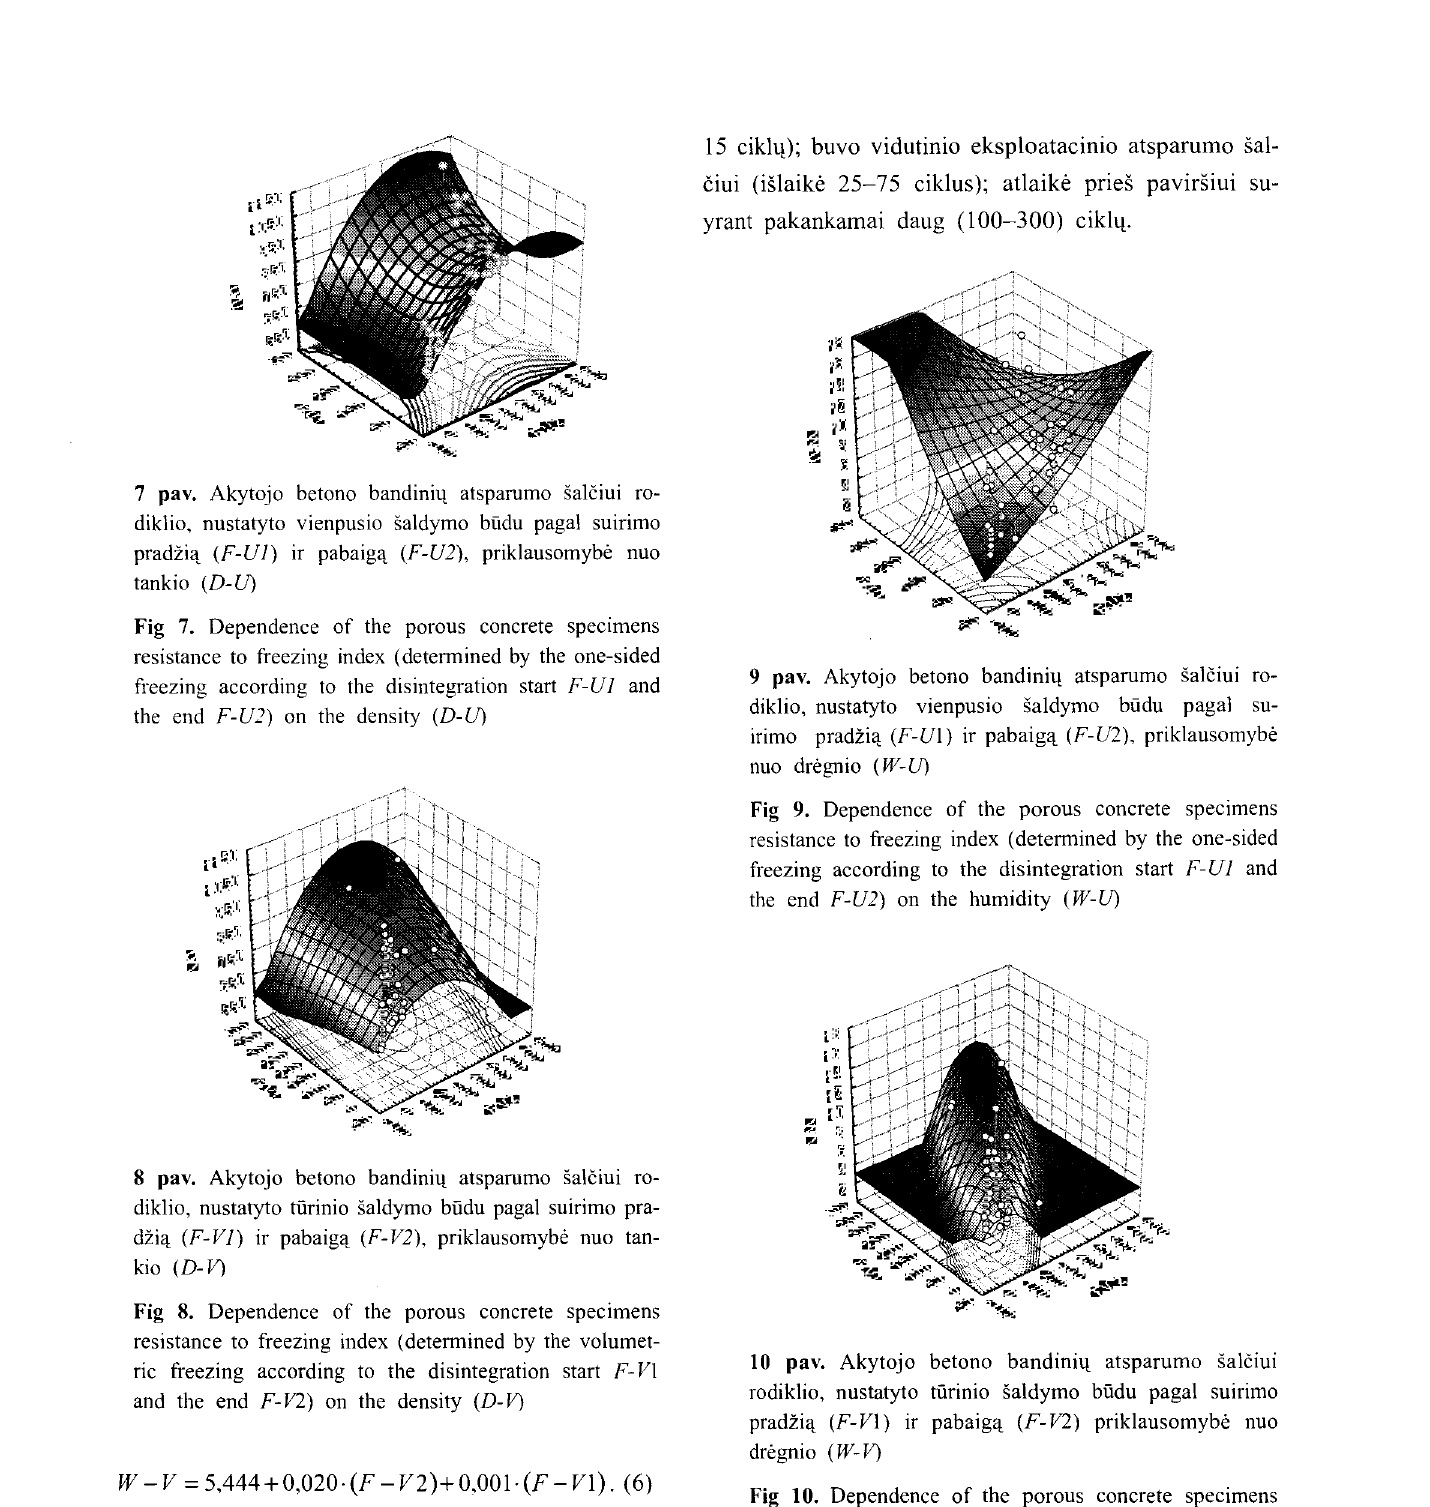
Fig 10. Dependence of the porous concrete specimens resistance to freezing index (determined by the volumet ric freezing according to the disintegration start F-VI and the end F- V2) on the humidity ( W- V) Pries aptariant tokitt tyrimtt rezultatus reikettt